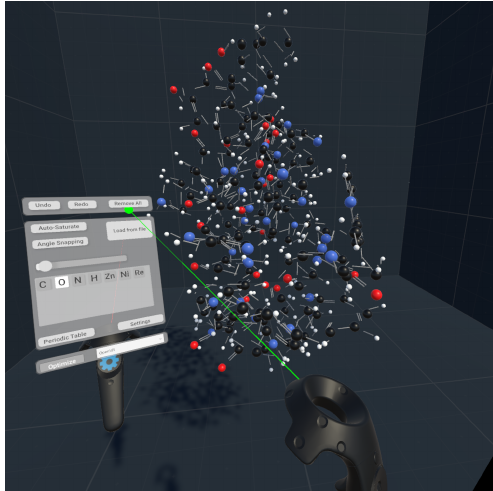
Figure 7. Atoms and bonds can be deleted by touching them with an extended thumb or pointing at them with a controller and using the delete button.